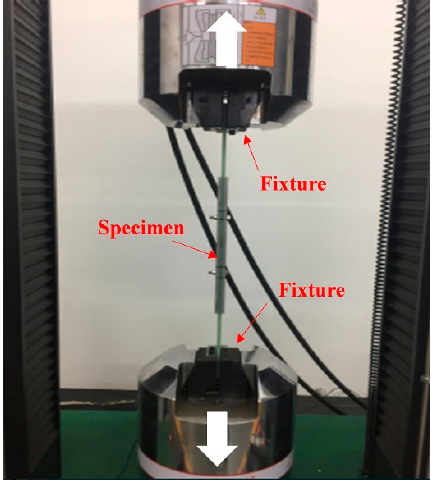
Figure 4. Loading equipment and testing